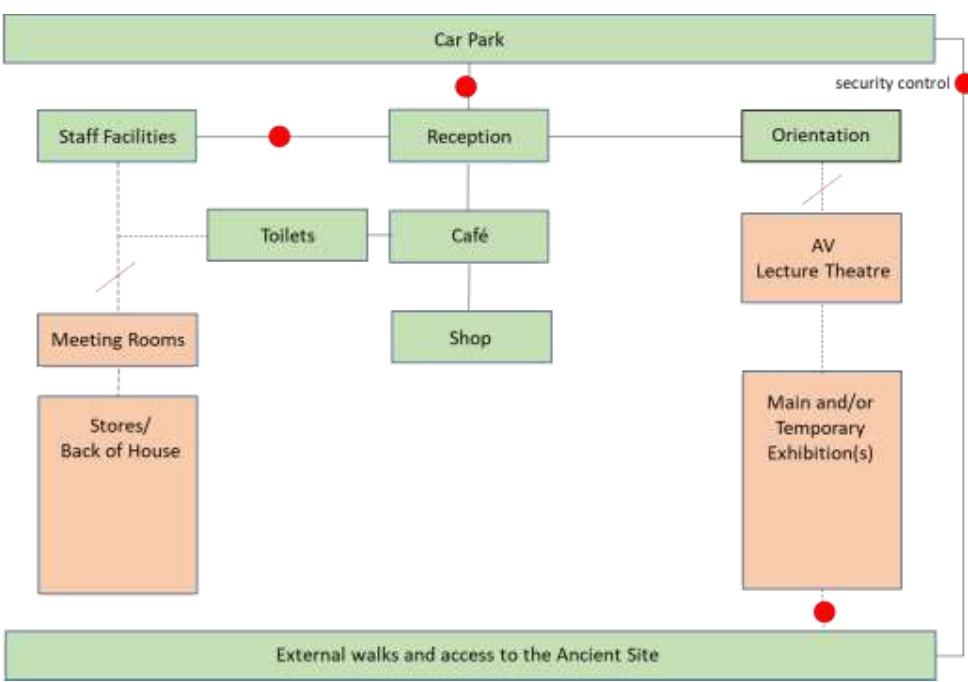
Figure 12: Proposed phases for the visitor centre (Phase 1=green; Phase